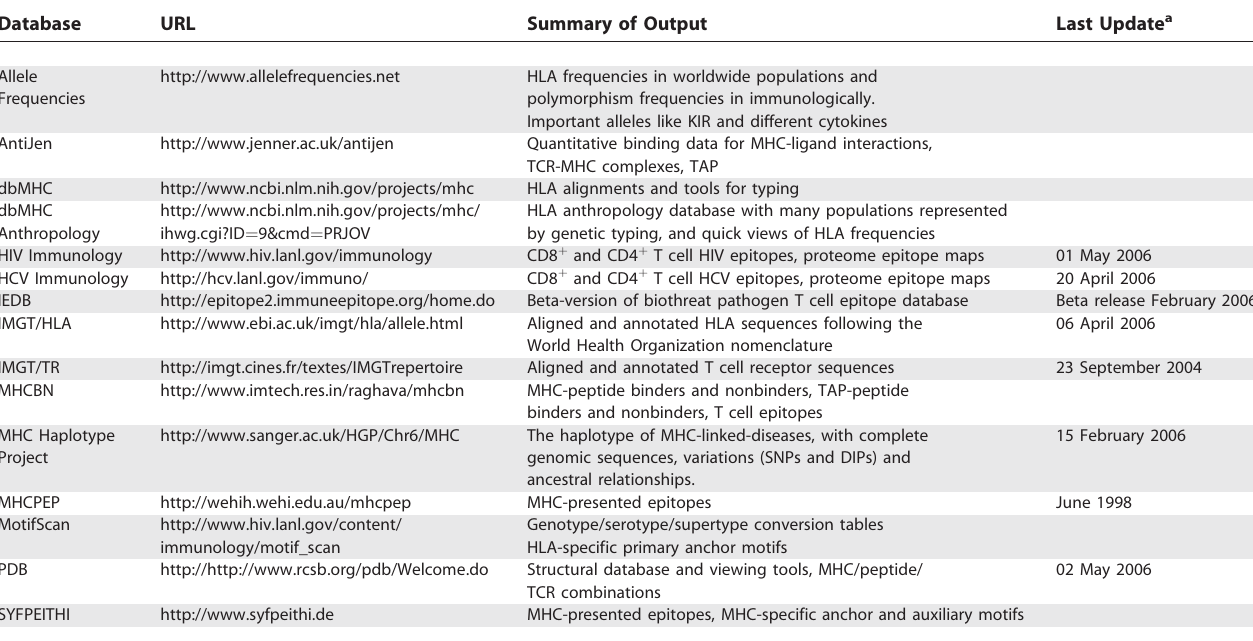
Table 2. T Cell-Related Immunological Databases and